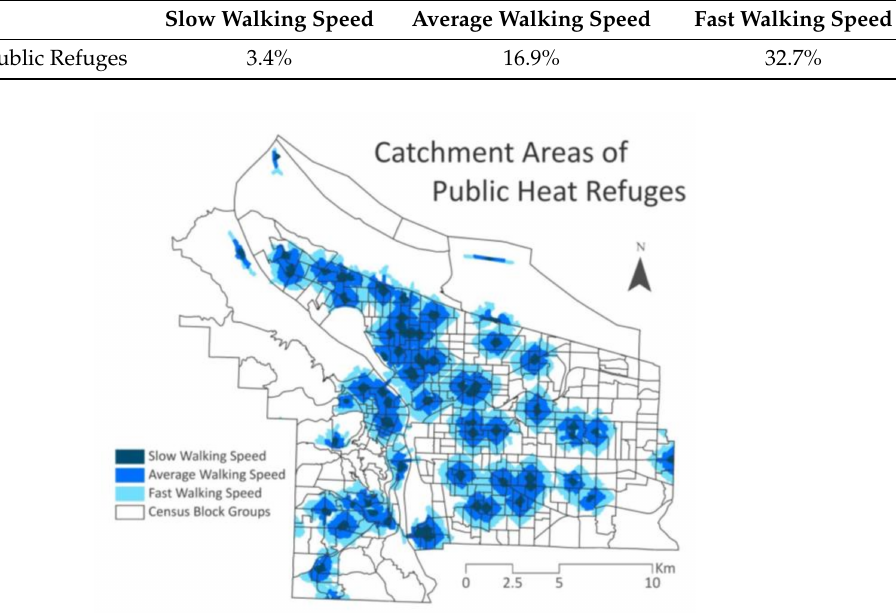
Figure 2. Catchment areas of public heat refuge access for slow, average, and fast